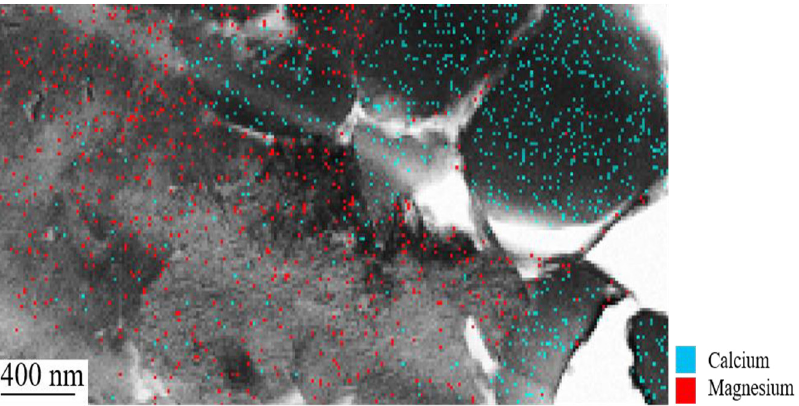
Figure 6. Example of elemental analysis performed on grain-scale by STEM. Blue represents occur- rences of calcium, red magnesium. Image modified from [10].